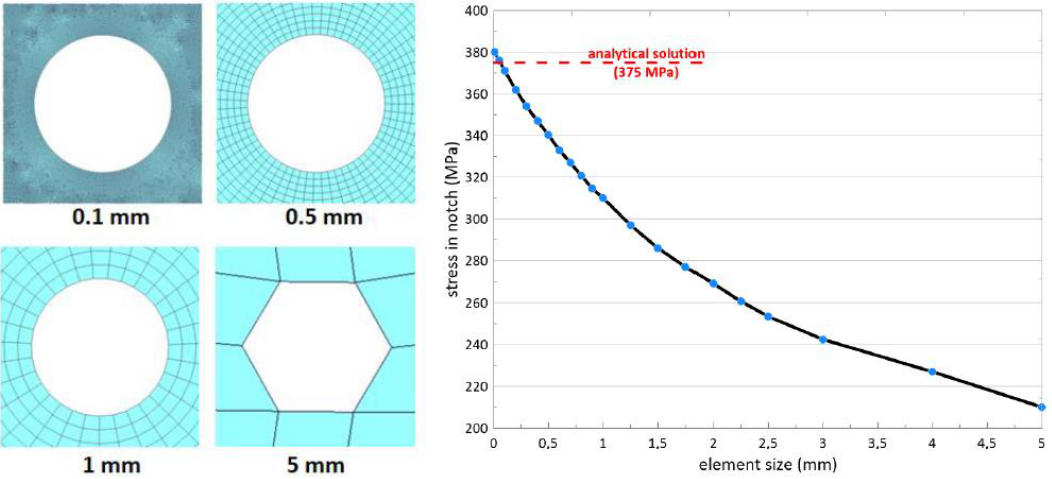
Figure 2. Mesh with an element sizes 0.1, 0.5, 1 and 5 (mm), and diagram of the peak stress in the root of the notch relative to element size